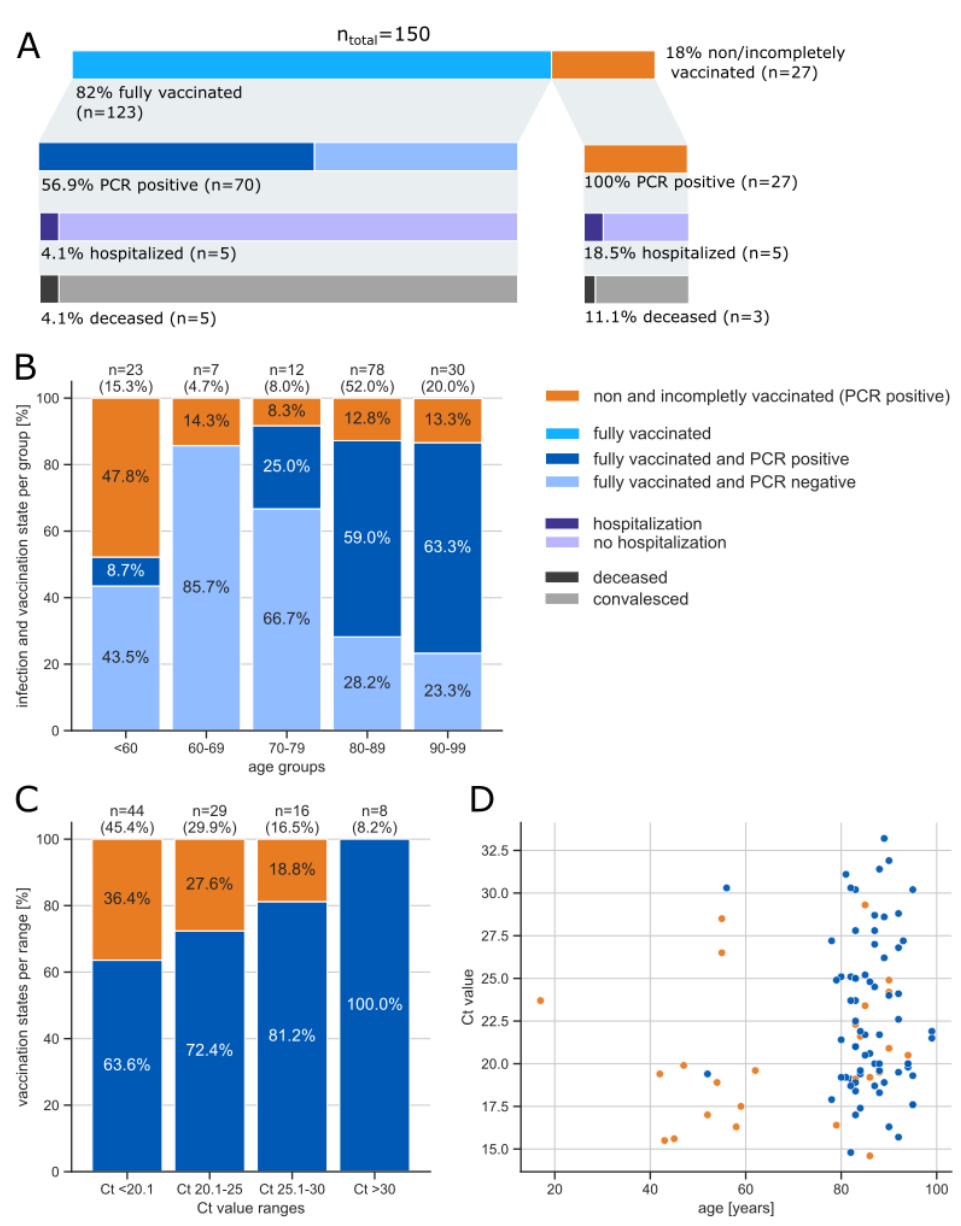
Figure 1. ( A ) Overview of the individuals considered in the investigated outbreak outlining the share of fully vaccinated and incompletely or non-vaccinated and the proportion of hospitalized and deceased by vaccination status. ( B ) Vaccination and infection status by age group. Fully vaccinated individuals can be divided into PCR positive (dark blue) and PCR negative (light blue) while all incompletely or non-vaccinated were PCR positive (orange). ( C ) Proportion of incompletely or non-vaccinated (orange) among PCR positive individuals in each Ct value group (fully vaccinated in blue). ( D ) Ct value distribution in relation to age among fully vaccinated ( n = 123, blue) and incompletely or non-vaccinated ( n = 27,